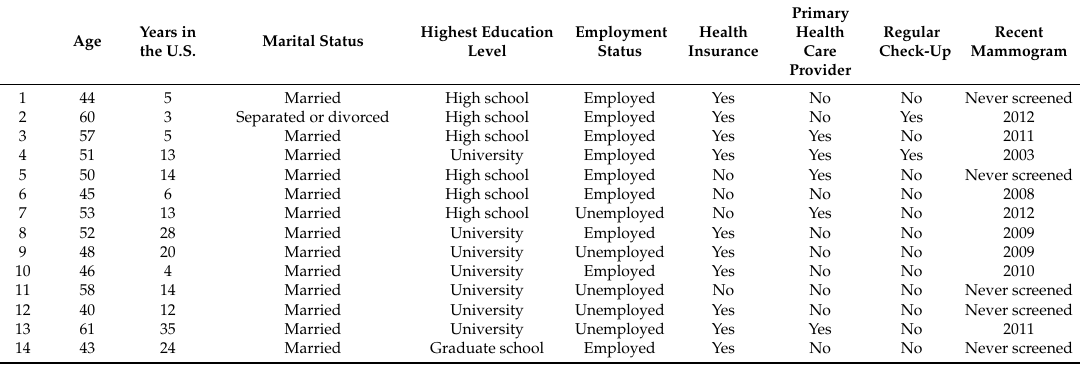
Table 1. The sociodemographics of study